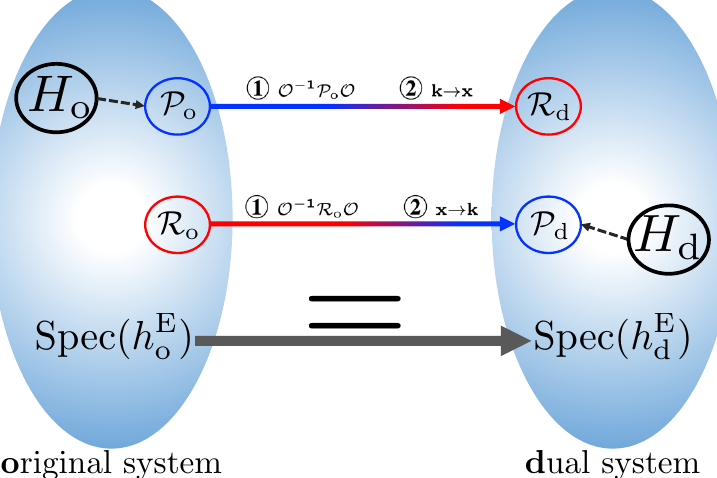
Figure 1: Schematic illustration of the duality. The duality between the original system H and the dual system H is split into two steps. In the first step 1 (cid:13) , o d